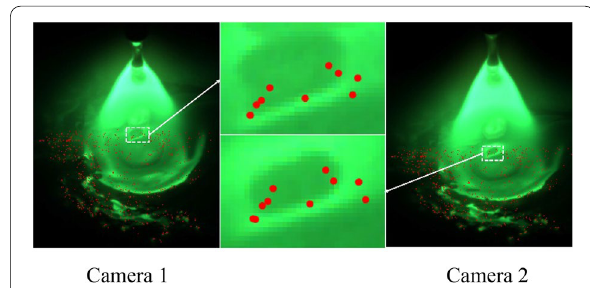
Figure 14 Matching pairs of the improved RANSAC algorithm (240 A, 33 V, 0.6